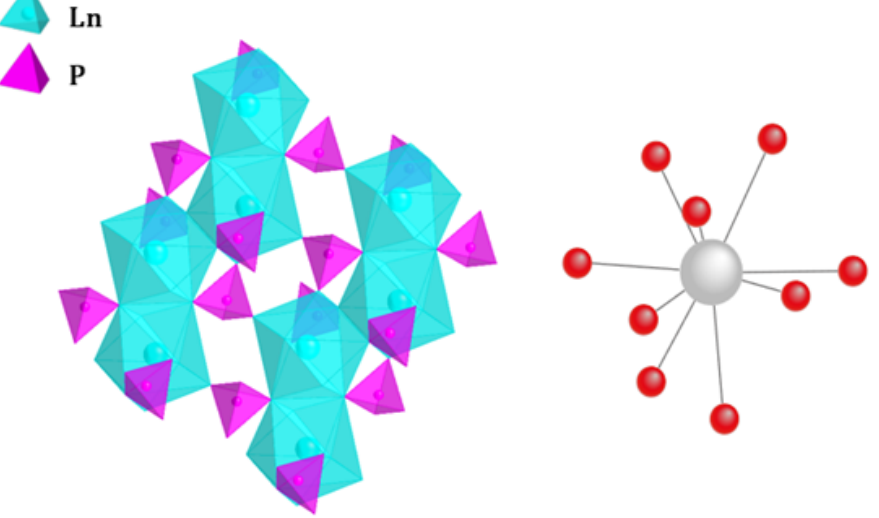
Figure 1. Schematic view of the crystal structure of monazite, LnPO 4 . (Done by the